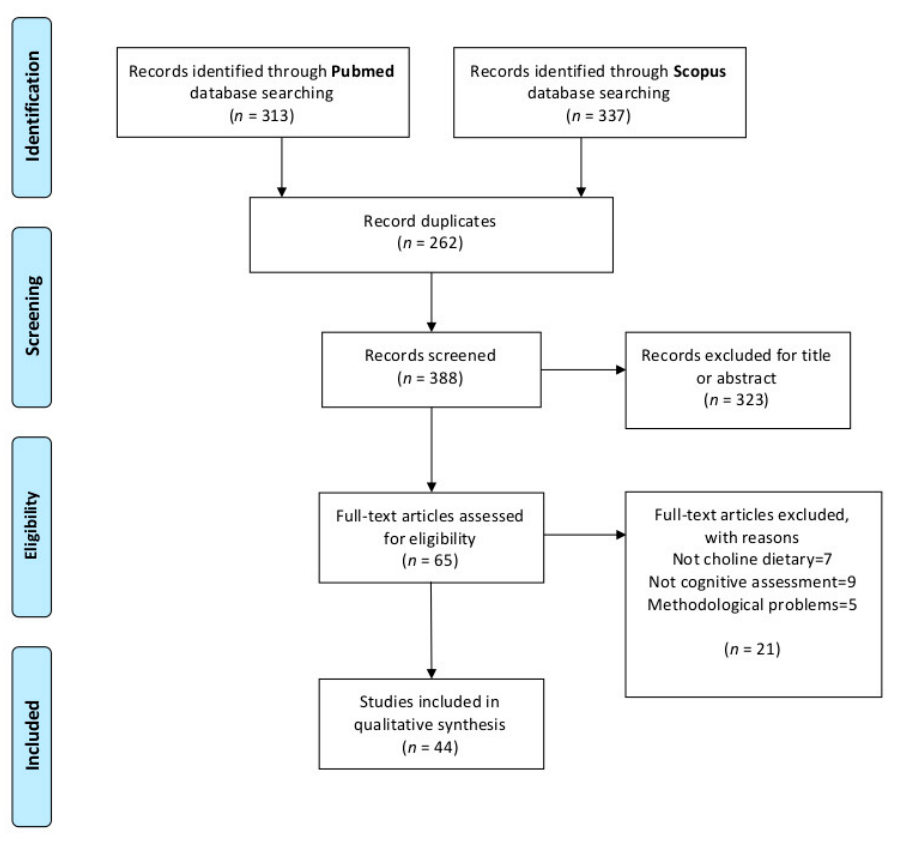
Figure 2. PRISMA (Preferred Reporting Items for Systematic Reviews and Meta-Analyses) flow diagram of papers selection for inclusion in the review .